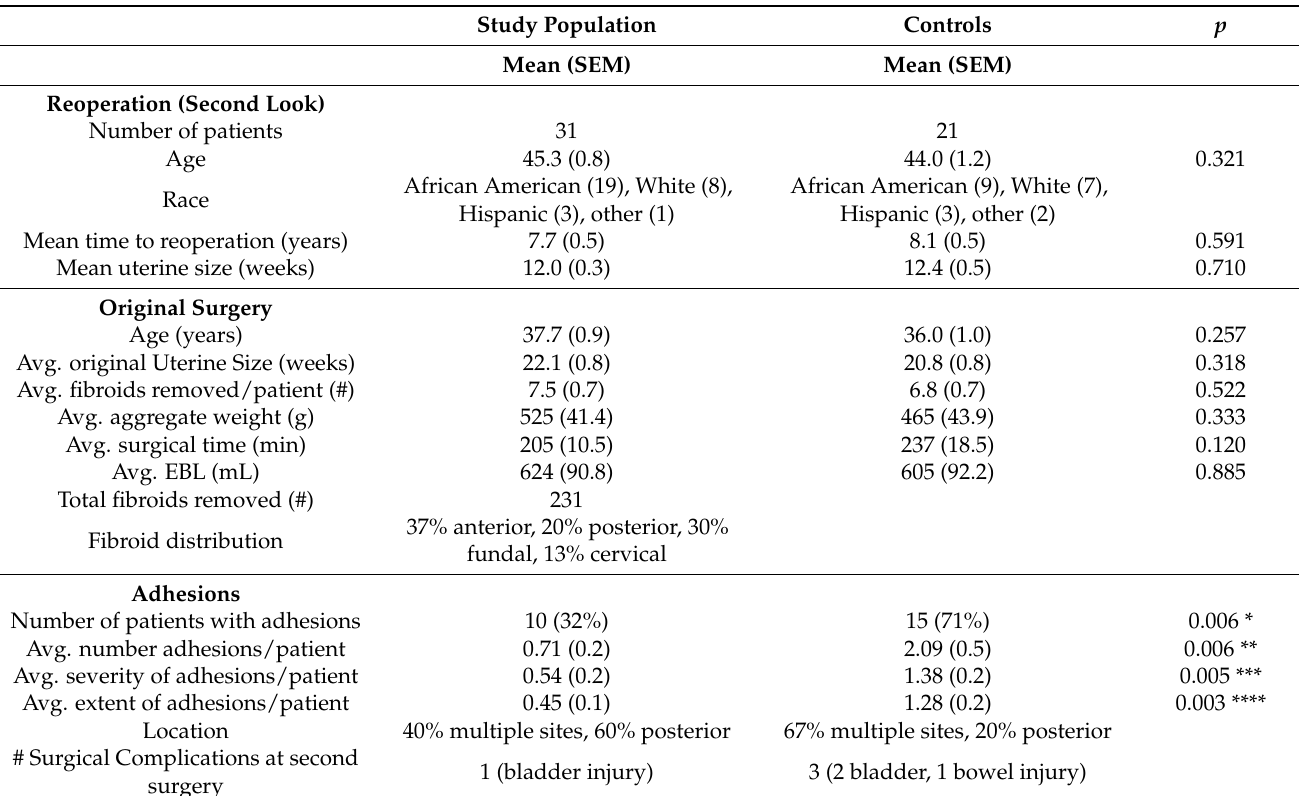
Table 2. Comparable patient demographics of the study and control populations. Using the interven- tion significantly reduced the adhesion number, severity, and extent of adhesions. SEM: standard error of the